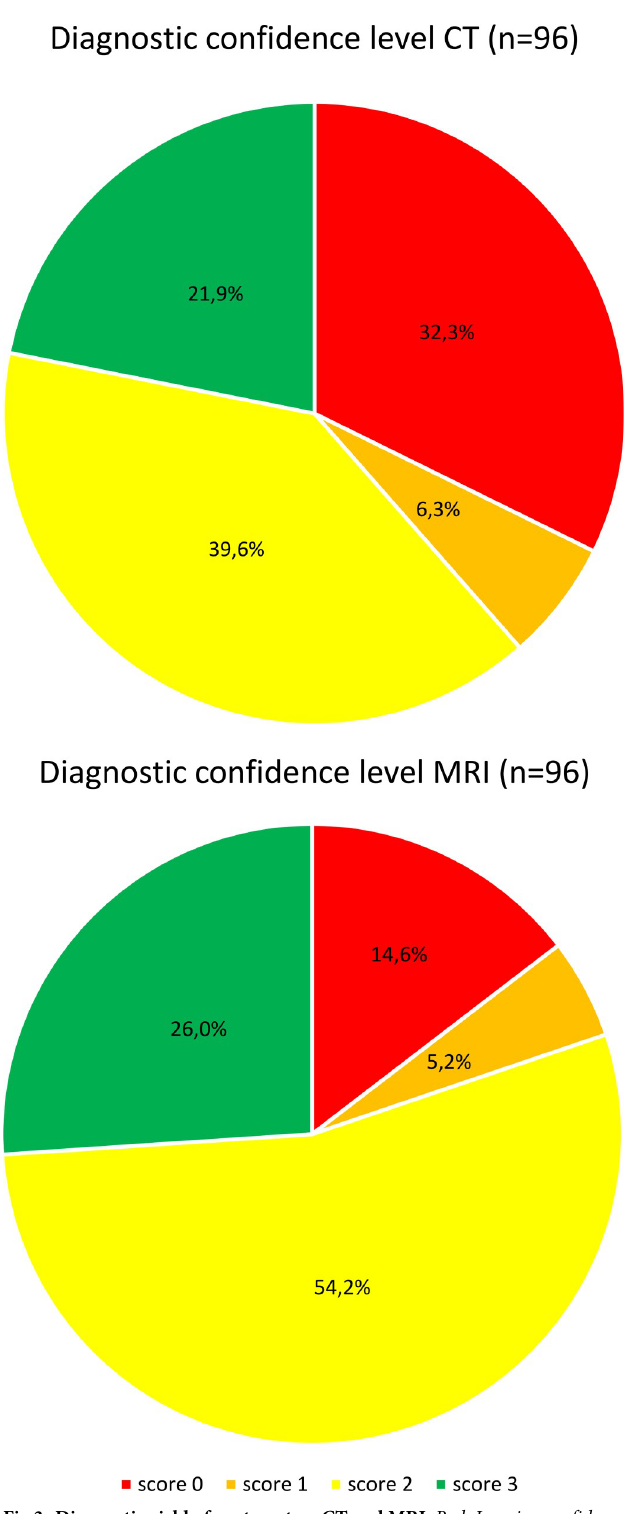
Fig 3. Diagnostic yield of postmortem CT and MRI. Red–Imaging confidence score 0 : diagnosis not detected; Orange– score 1 : diagnosis detected on imaging, but unclear; biopsy required; Yellow–score 2 : diagnosis seen on imaging and likely , biopsy required for confirmation; Green—score 3 : diagnosis certain , no biopsy required .